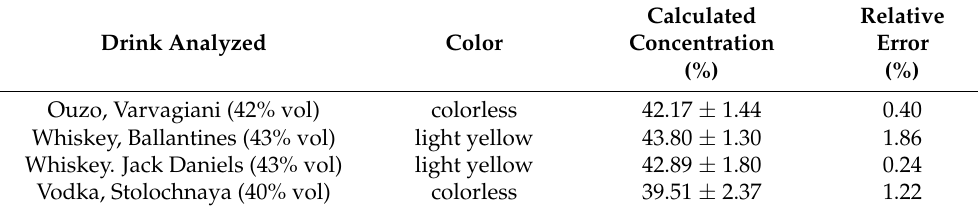
Table 4. Ethanol concentration in spirits calculated using the portable Raman setup and the “through the container” method. Deviation to the label value (relative error) is also quoted (*). Calculated Relative Drink Analyzed Color Concentration Error (%) (%) Ouzo, Varvagiani (42% vol) colorless 42.17 ± 1.44 0.40 Whiskey, Ballantines (43% vol) light yellow 43.80 ± 1.30 1.86 Whiskey. Jack Daniels (43% vol) light yellow 42.89 ± 1.80 0.24 colorless 39.51 ±